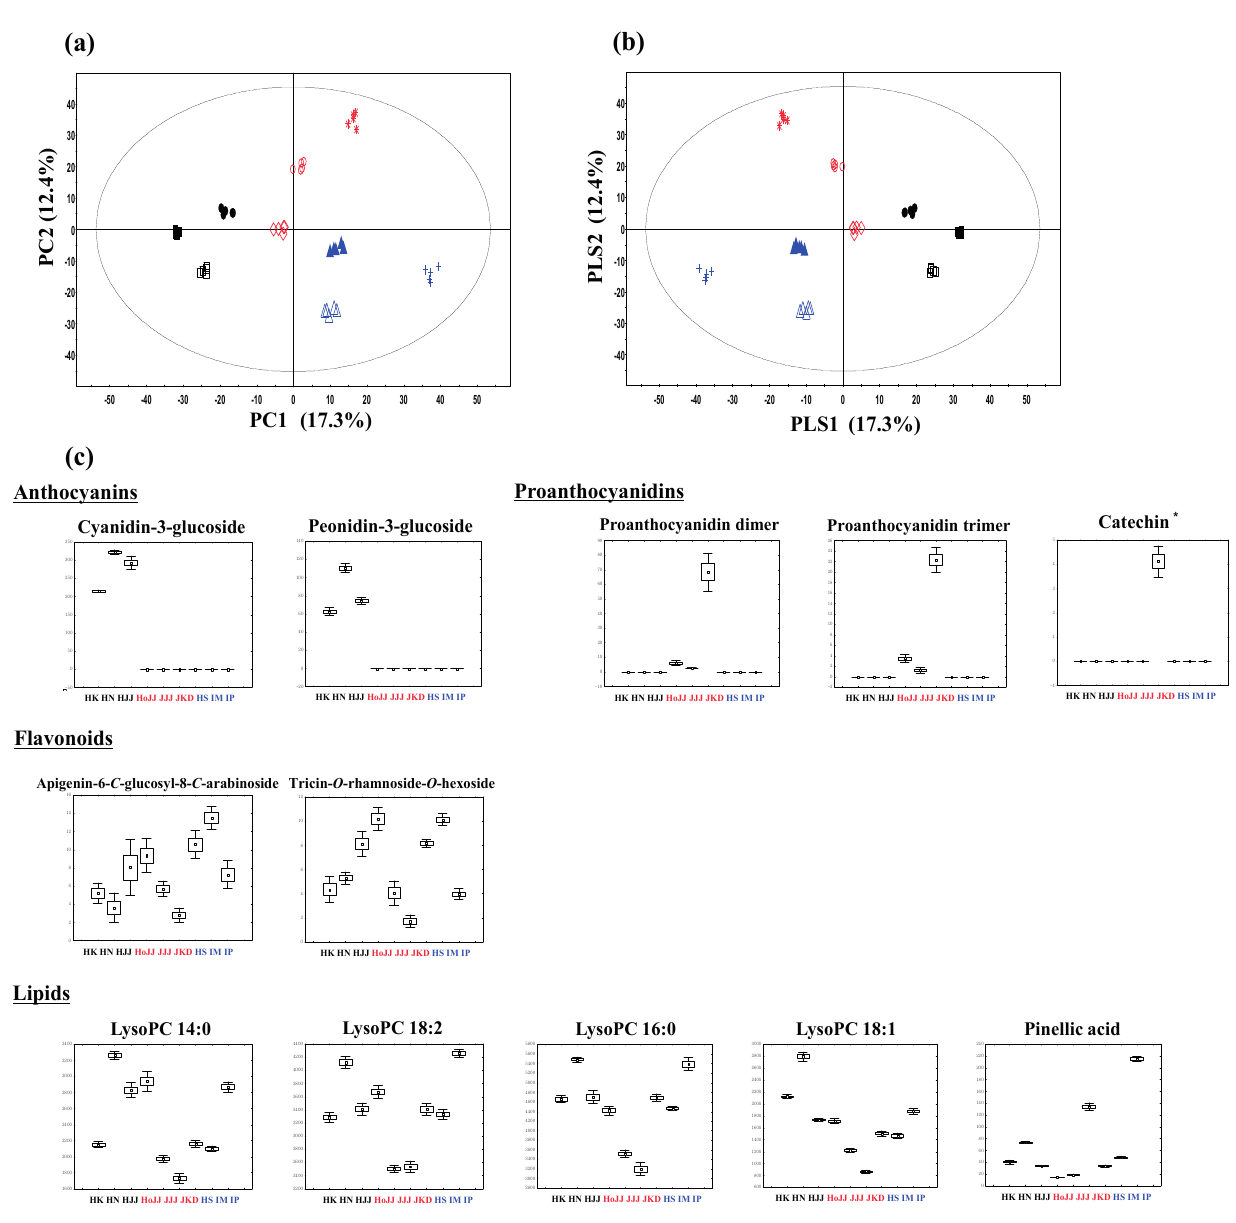
Figure 1. The principal component analysis (PCA) score plots ( a ), partial least-square discriminant analysis (PLS-DA) score plots ( b ), and box-whisker plots ( c ) of nine different varieties of rice seeds analyzed by UPLC-Q-TOF-MS. Black rice seed: ● HK (Heugkwang), □ HN (Heugnam), ■ HJJ (Heugjinju); Red rice seed: ◇ HoJJ (Hongjinju), ○ JJJ (Jeogjinju), ж JKD (Jakwangdo); White rice seed: ▲ HS (Hwaseong), + IM (Ilmi), △ IP (Ilpoom). * Target